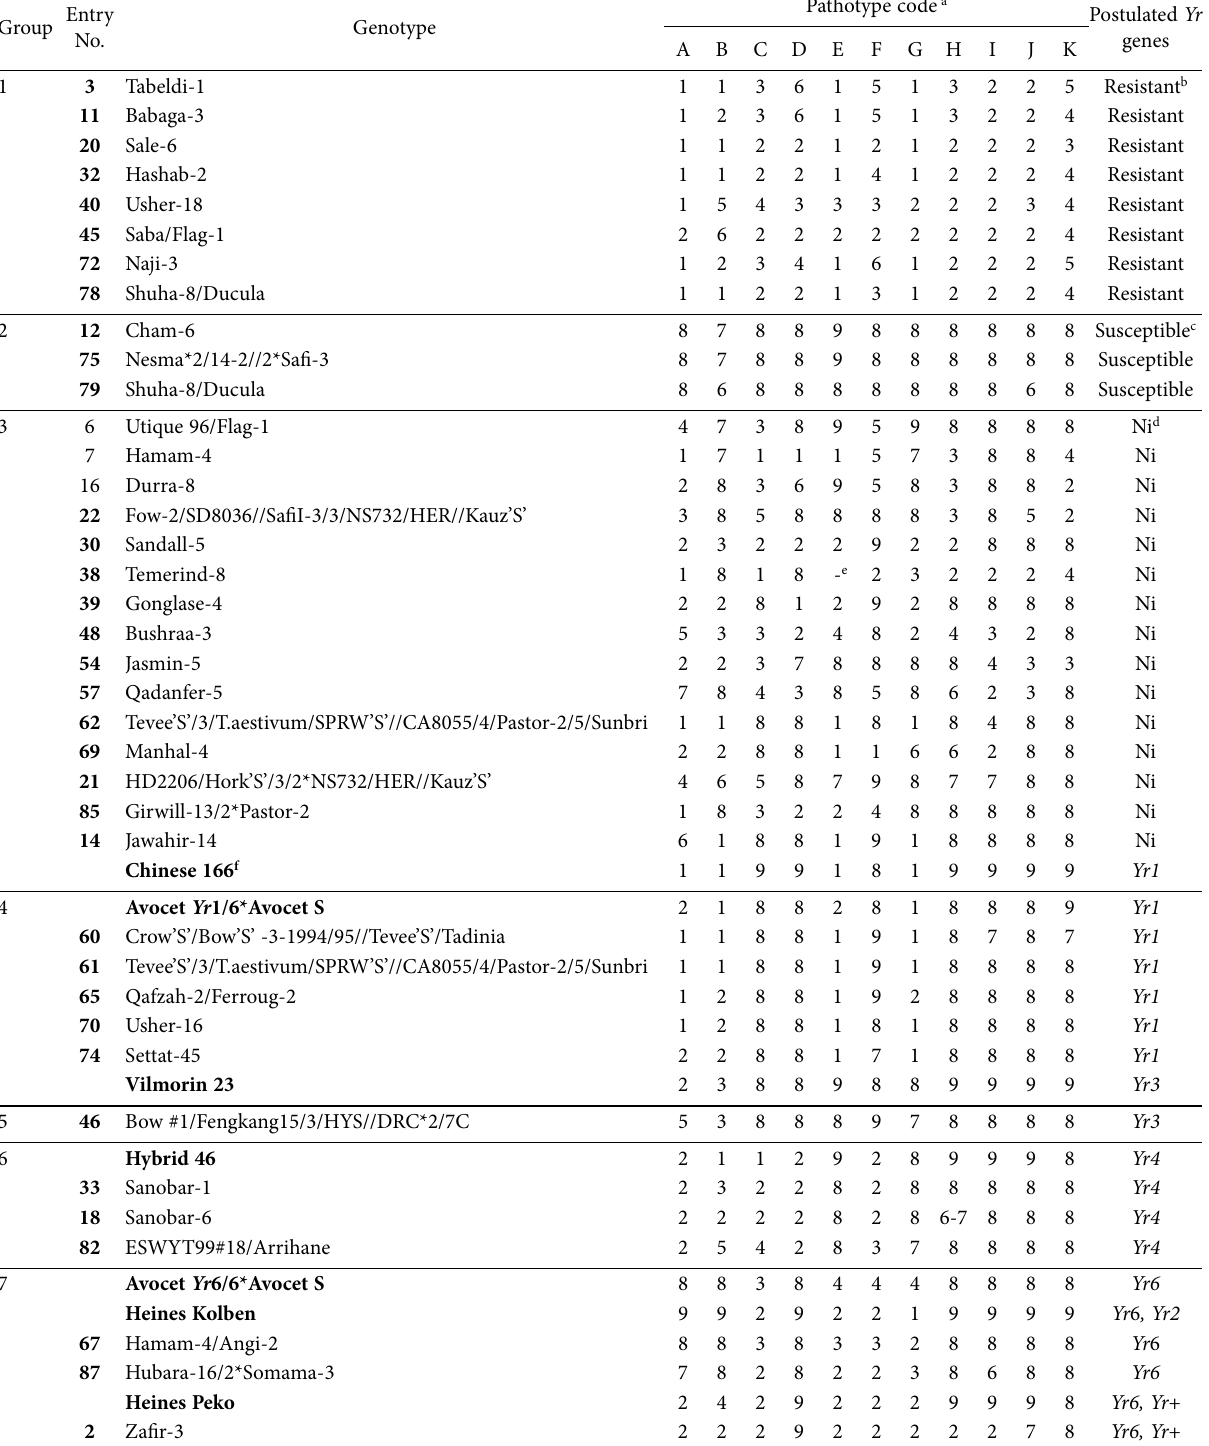
Table 2. Resistance group, seedling infection types and postulated stripe rust resistance genes in 87 wheat elite lines from ICARDA, tested against 11 Puccinia striiformis f. sp. tritici